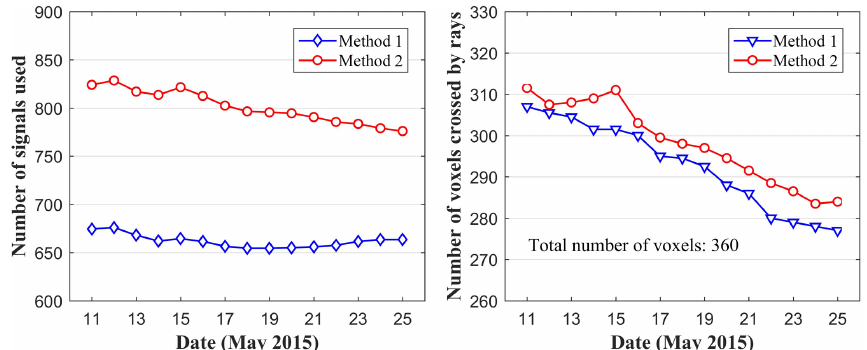
Figure 6. The number of signals used and the number of voxels crossed by rays for the experimental period.